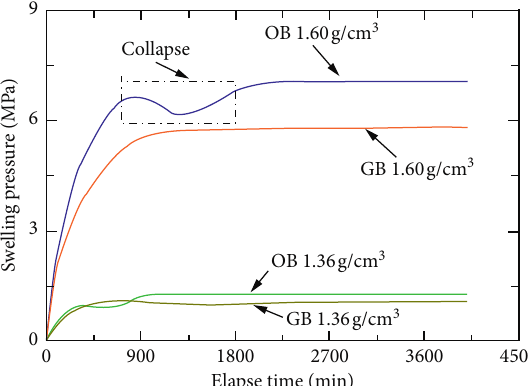
Figure 7: Evolution of swelling pressure of original and granular